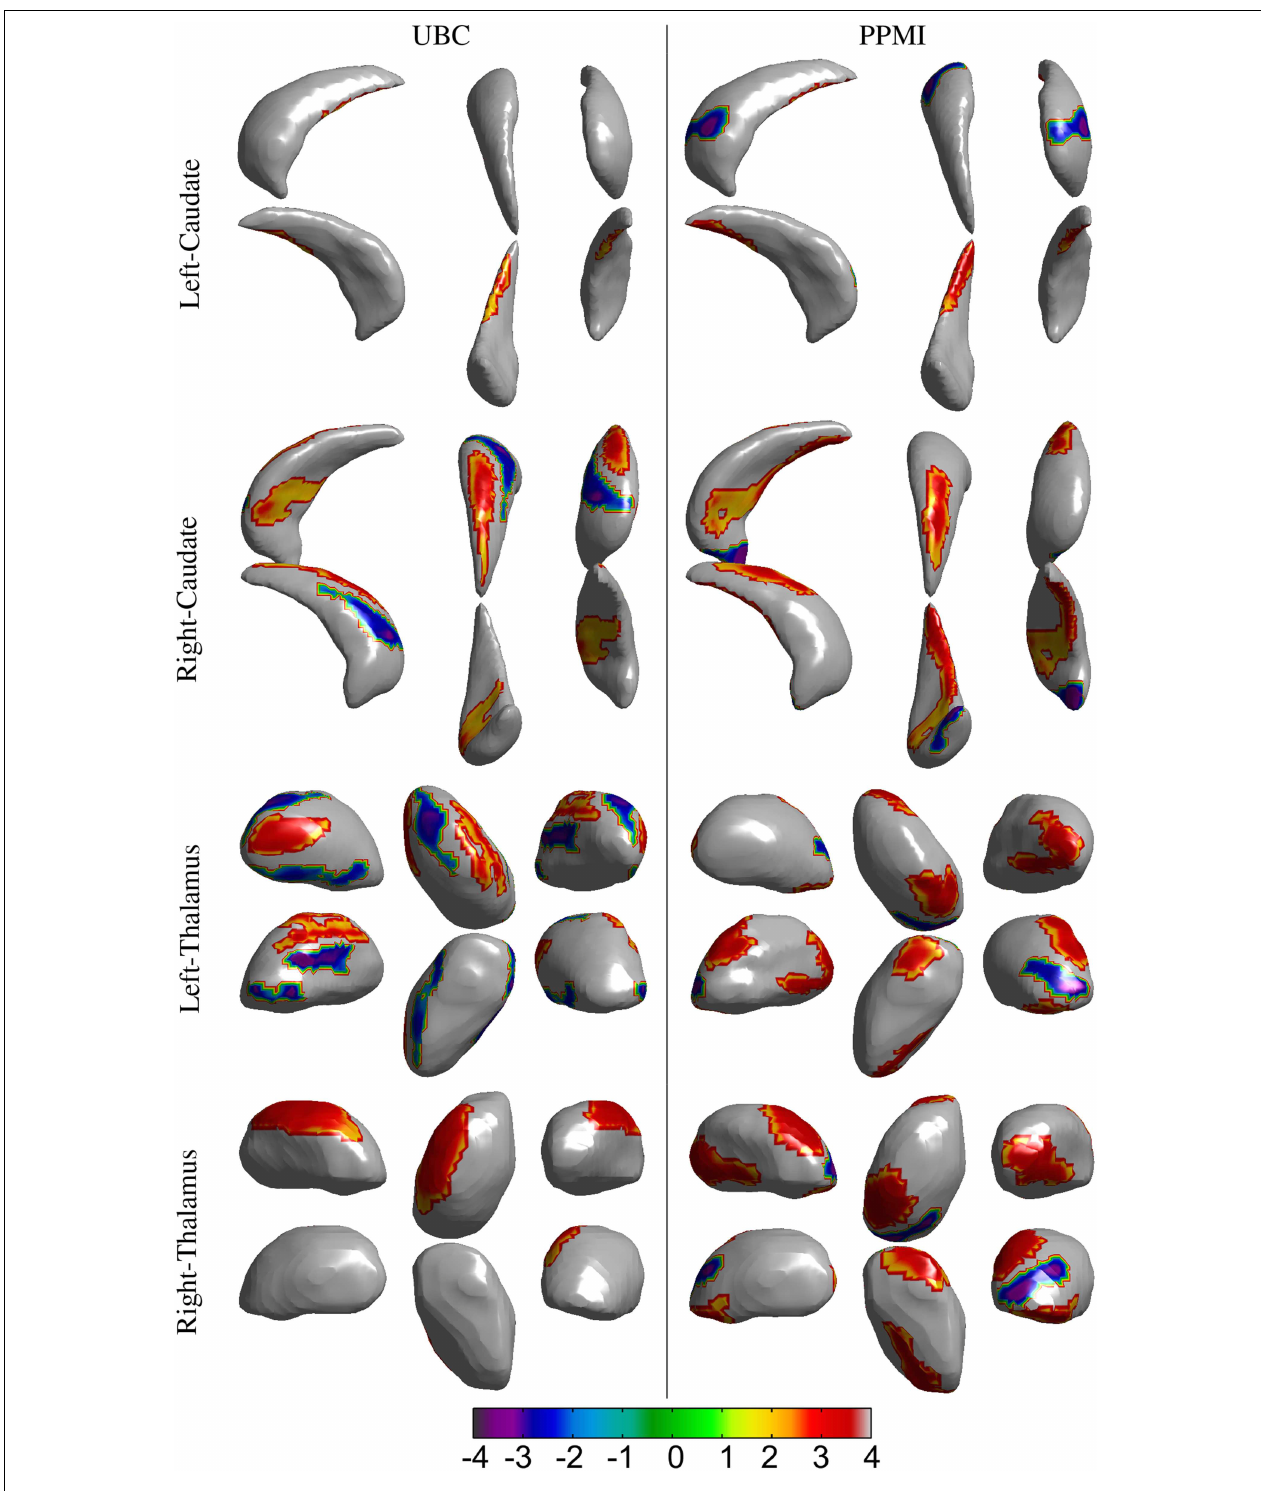
FIGURE 4 | Results for the vertex-wise group difference analysis of the surface displacement data for the left and right, caudate and thalamus structures in the UBC and PPMI datasets. The colored patches represent the t -values in the areas